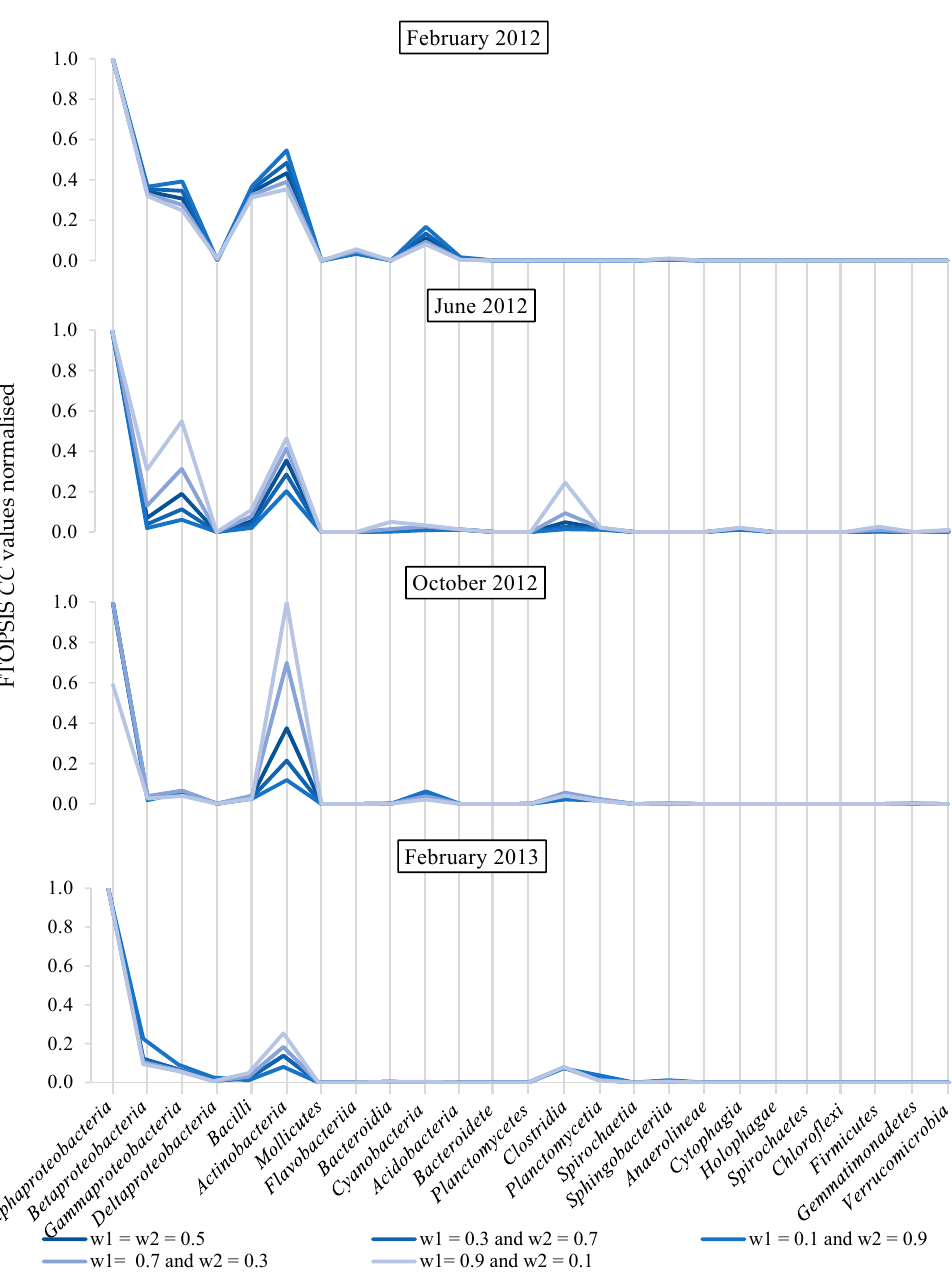
Figure 4. Sensitivity analysis on normalised 𝐶𝐶 values by varying criteria weights.